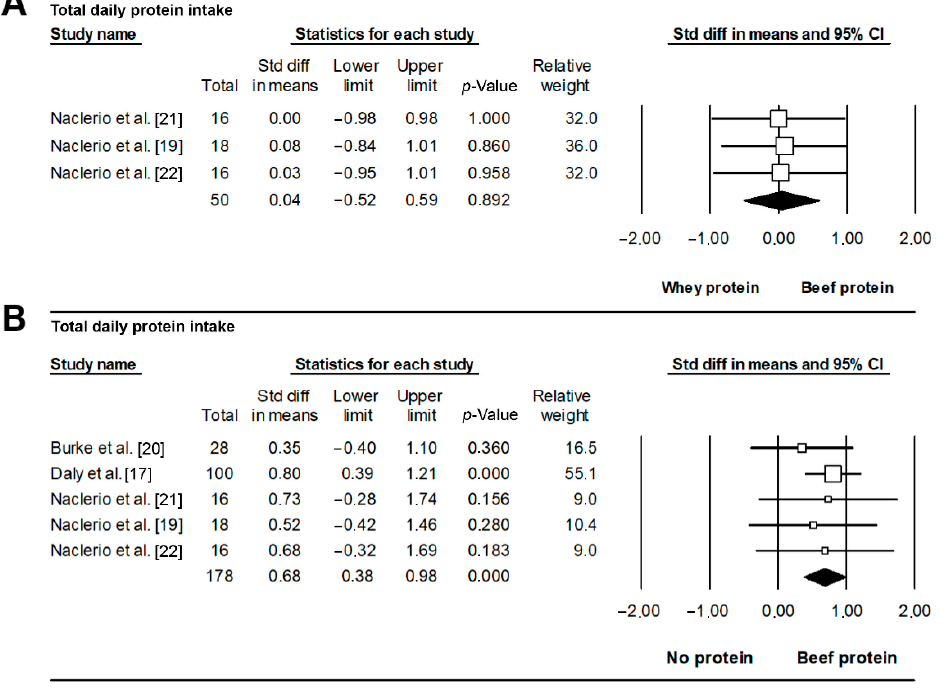
Figure 5. Effects on total daily protein intake of beef vs. whey ( A ) or no protein supplementation ( B ). Each forest plot displays the pooled standardized difference in means and 95% confidence